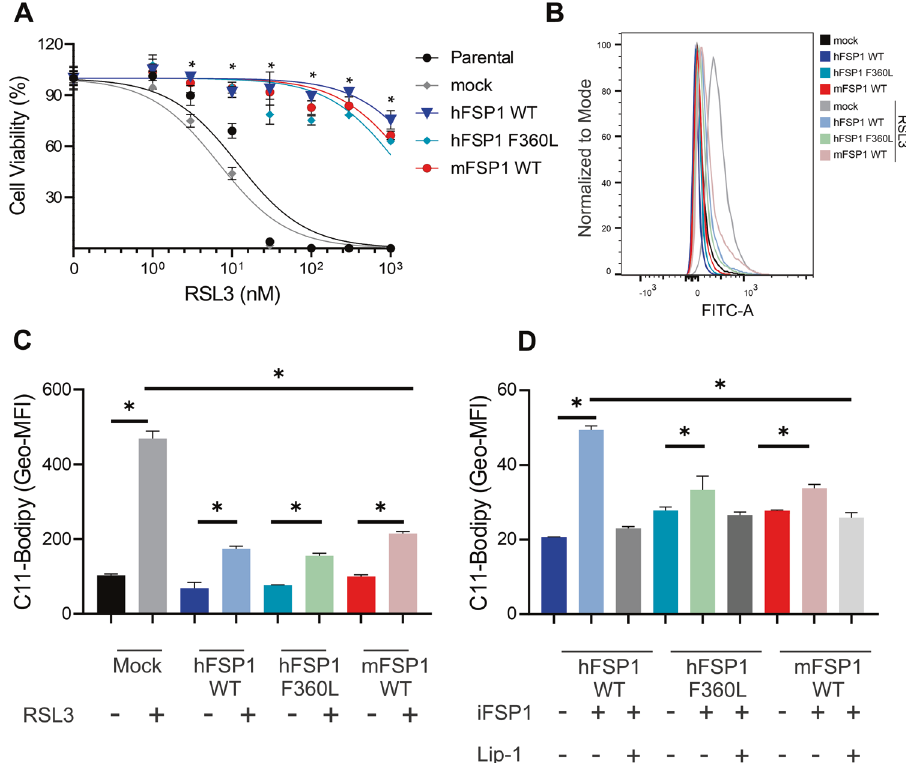
Fig. 3 F360L mutation does not interfere with FSP1 activity. A Dose-response toxicity to iFSP1 in Pfa1 Gpx4 WT overexpressing the hFSP1, mFSP1 and hFSP1 F360L mutant. Cell viability data was monitored using Alamar blue. Data are presented as mean ± s.d. of n = 3 wells of a 96- well plate from one representative of three independent experiments; * p < 0.05; two-way analysis of variance (ANOVA). Flow cytometry analysis of BODIPY 581/591 C11 oxidation induced by RSL3 treatment (300 nM for 3 h) in Pfa1 Gpx4 WT cell line overexpressing hFSP1, mFSP1 and hFSP1 F360L mutant. B Histogram ( C ) bar graphs of the geometric mean fl uorescence intensity (Geo-MFI). D Flow cytometry analysis of BODIPY 581/591 C11 oxidation induced by iFSP1 treatment (3 µM for 3 h) with or without liproxstatin 1 (Lip-1) in Pfa1 Gpx4 − / − cell line overexpressing hFSP1, mFSP1 and hFSP1 F360L mutants. Bar graphs depict the geometric mean fl uorescence intensity (Geo-MFI). Data are presented as mean ± s.d. of n = 3 wells of one representative of two independent experiments; * p < 0.05; one-way analysis of variance (ANOVA) with post-hoc